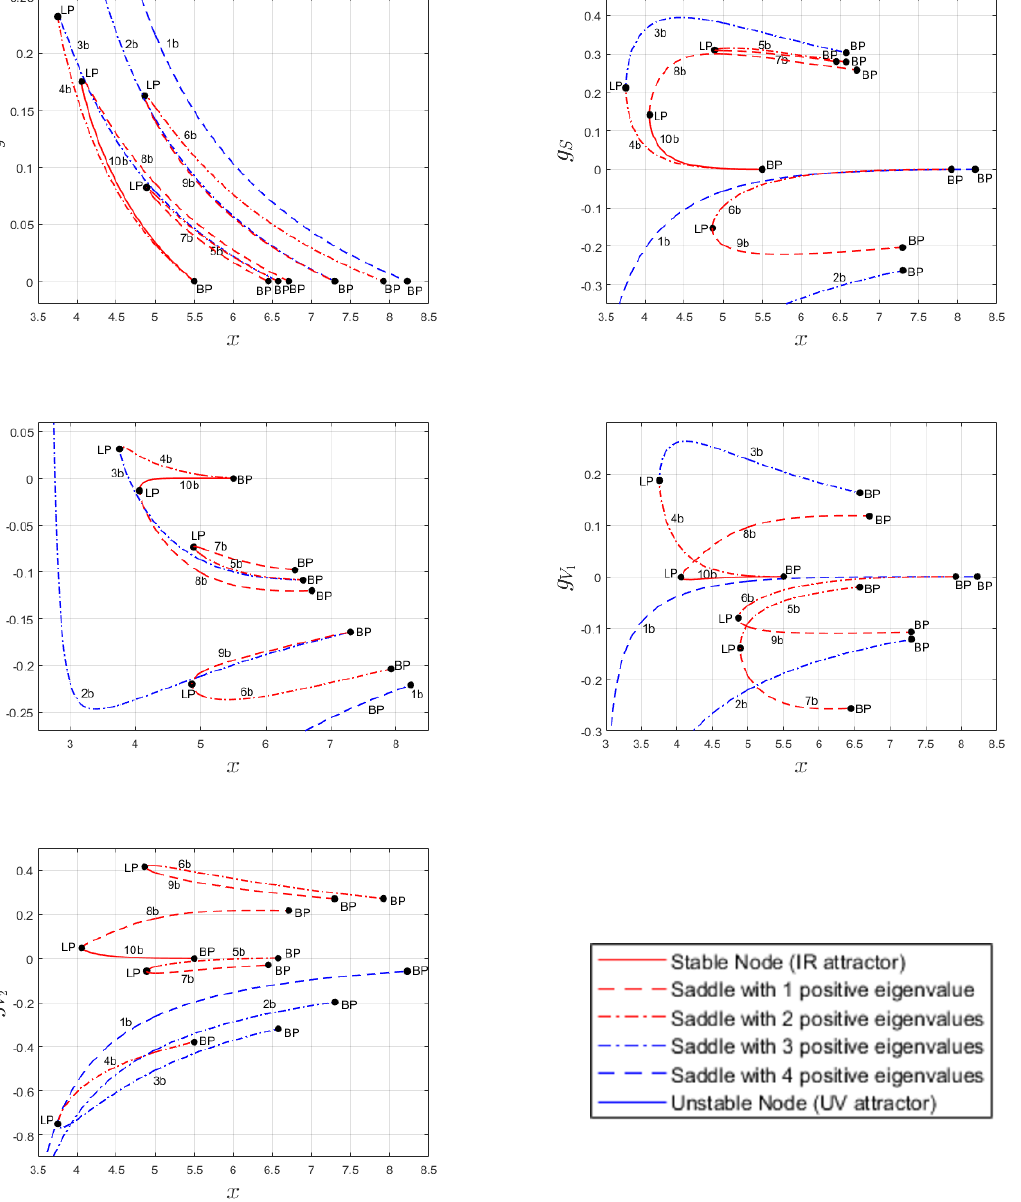
Figure 8. Fixed points with (cid:11) g > 0 in the QCD 4 model (2.7) at N c = 3, as a function of x . LP: Limit Point (Saddle-Node Bifurcation). BP: Branching Point (Transcritical Bifurcation), point where the non-trivial equilibrium obtains a value (cid:11) g > 0. Numbers indicate the equilibria, and correspond to the numbers in (cid:12)gure 6.